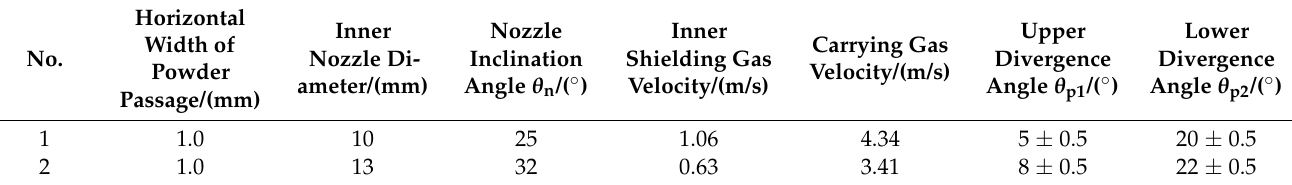
Table 5. The process parameters in [13].